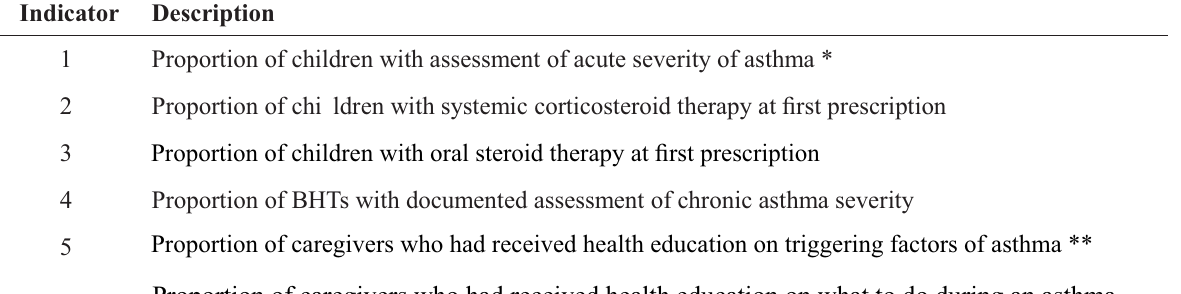
Table 1: List of clinical indicators to determine quality of managing childhood asthma